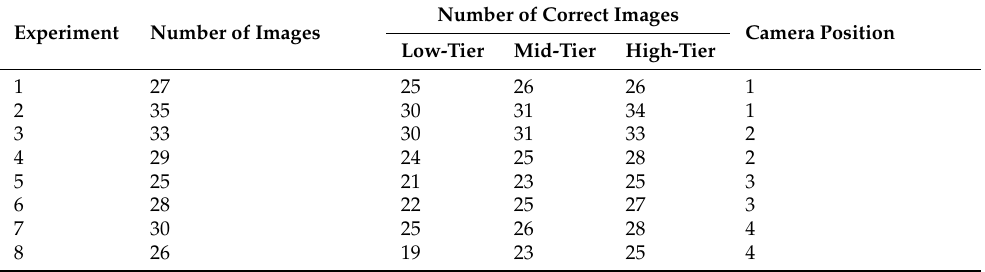
Table 7. Model performance with respect to the camera position (Number of correctly identified im-